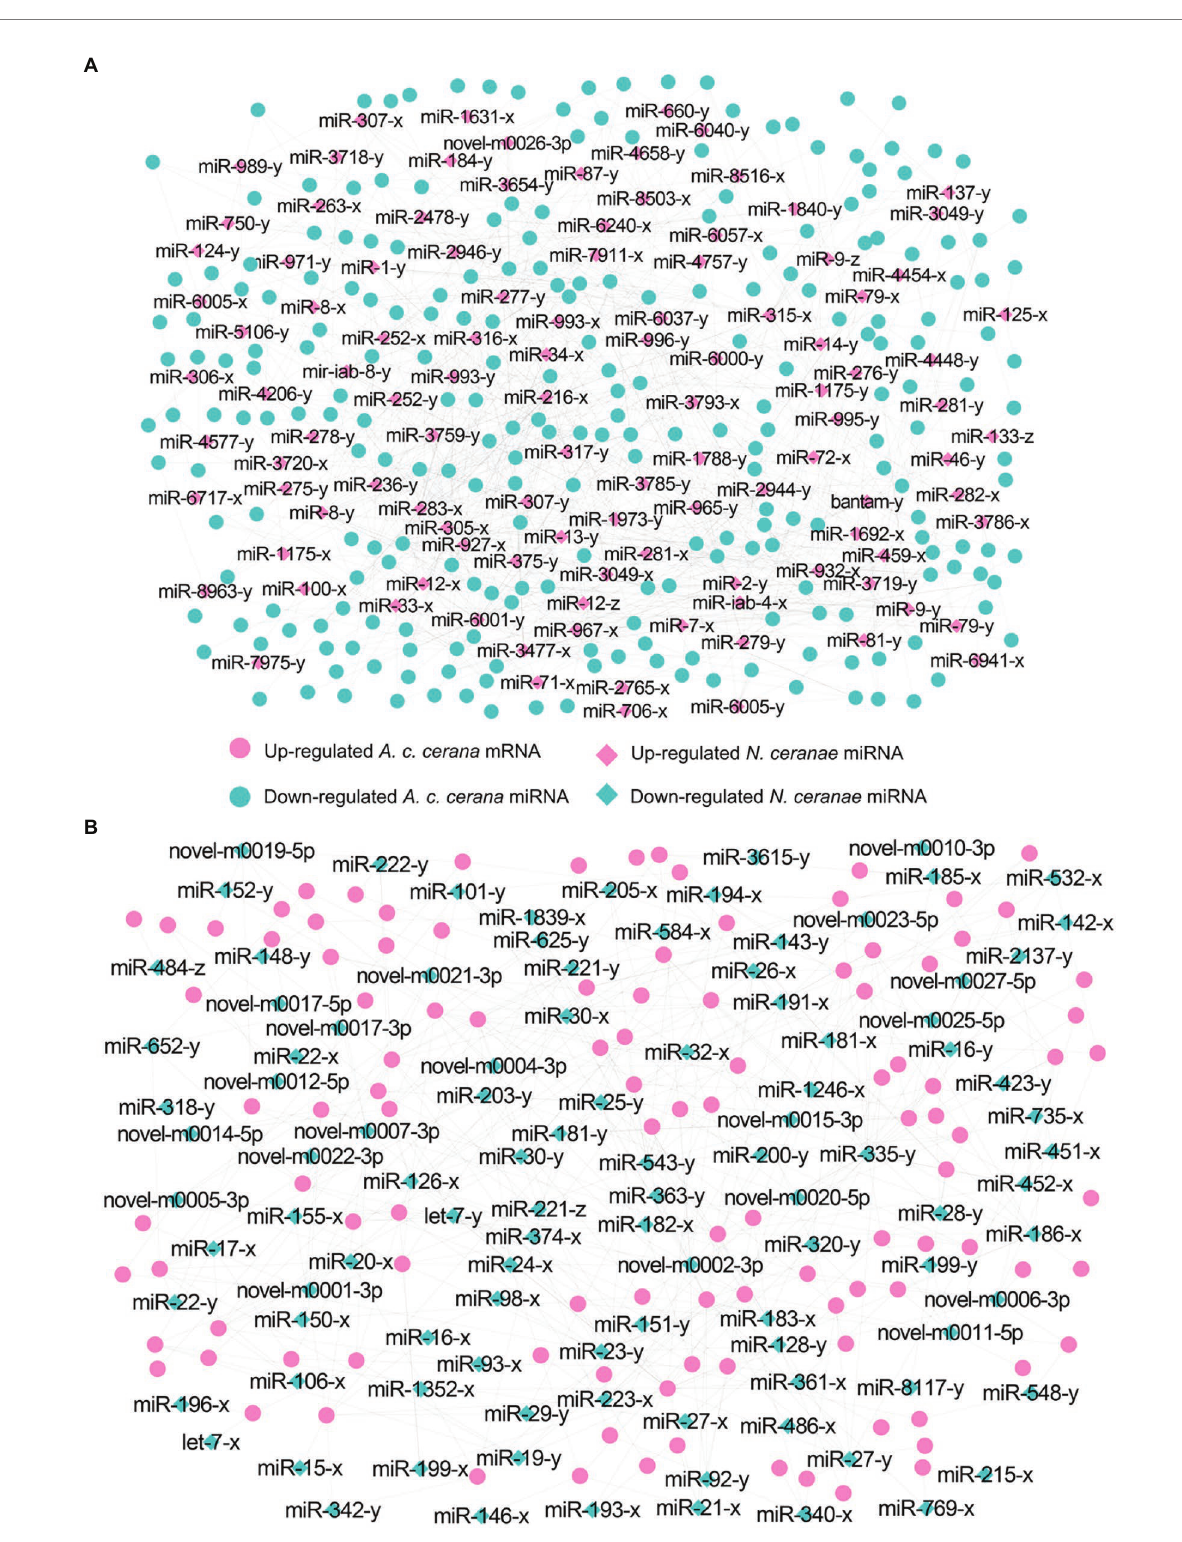
FIGURE 6 Regulatory networks of N. ceranae DEmiRNAs and target DEmRNAs in A. c. cerana workers’ midguts at 10 dpi. (A) Regulatory network between up-regulated miRNAs in microsporidian and down-regulated mRNAs in host. (B) Regulatory network down-regulated miRNAs in microsporidian and up-regulated mRNAs in